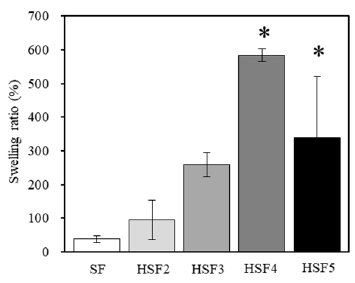
Figure 5. The swelling ratios of SF and heparin modified (HSF2, HSF3, HSF4, and HSF5) samples (* p < 0.05 relative to SF).